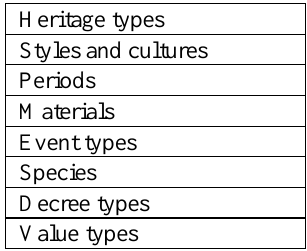
Table 2. Overview thesauri